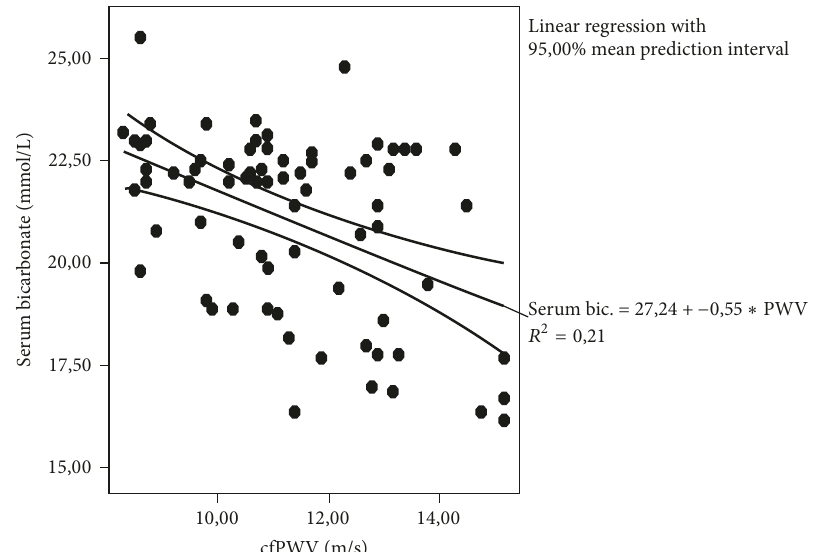
Figure 3: The correlation between carotid-femoral pulse wave velocity (c-fPWV) and serum bicarbonate concentrations ( 𝑟 = −0.377 , 𝑝 = 0.001 ).